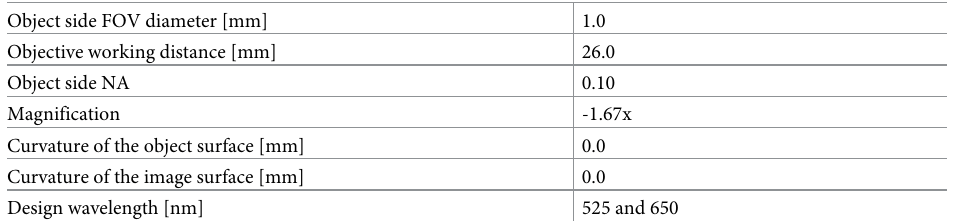
Table 1. Summary of optical design parameters for the UV fluorescence